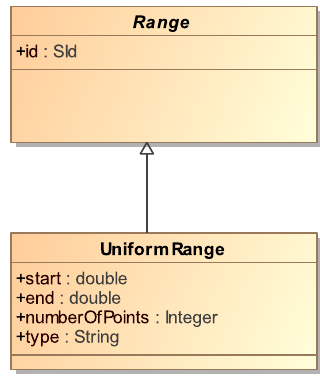
Figure 2.35: The SED-ML UniformRange class